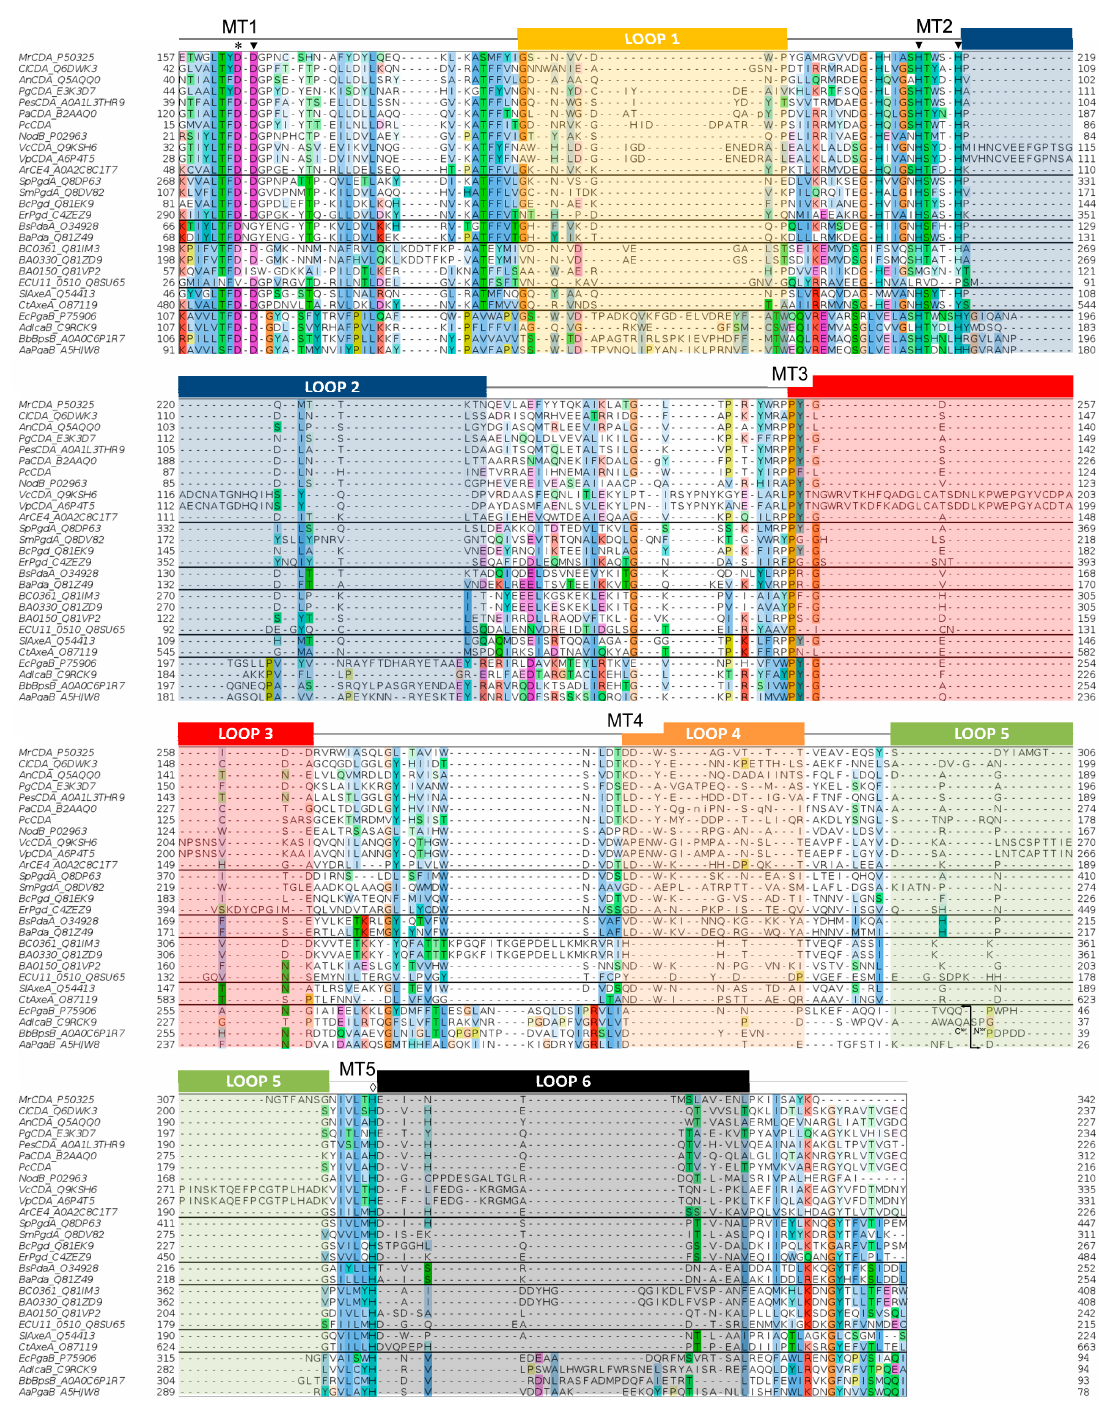
Figure 4. Multiple sequence alignment of the CE4 enzymes listed in Table 1. Loops are highlighted with colored boxes according to [62]. Conserved catalytic motifs are labelled MT1–5. The “His–His–Asp” metal binding triad ( (cid:72) ), catalytic base (*), and catalytic acid ( ♦ ) are labelled. The mark inside Loop 5 for poly- β -1,6-GlcNAc deacetylases (four last sequences) indicates the shuffling point of the circularly permuted CE4 domain.